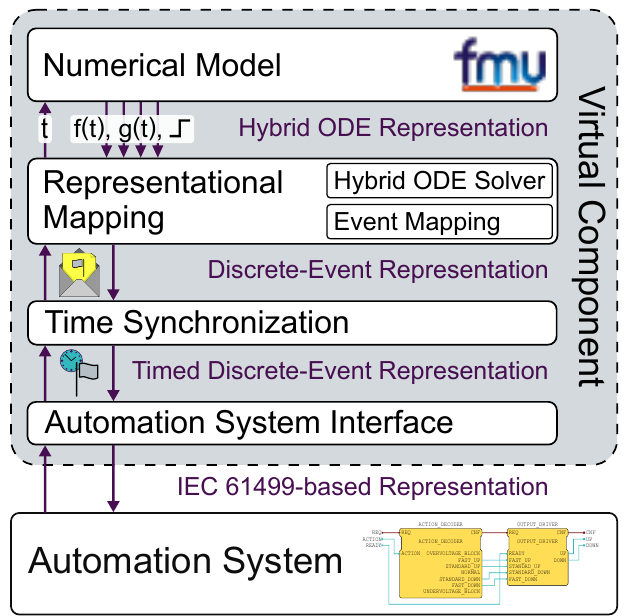
Figure 1. Abstract system